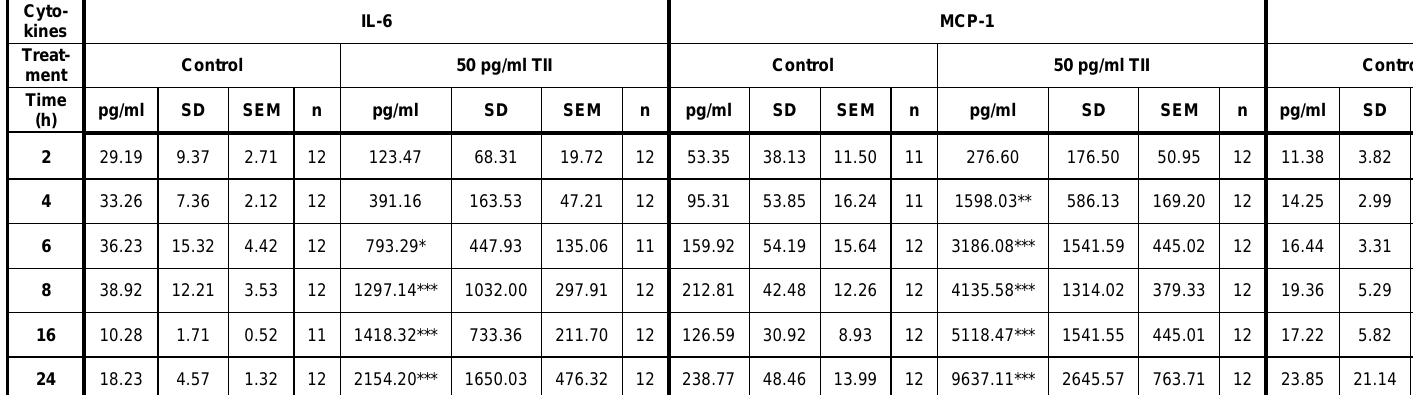
Table 1: Release of cytokines by C20 cells stimulated with TII for different times (2 h-24 h) Cyto- kines